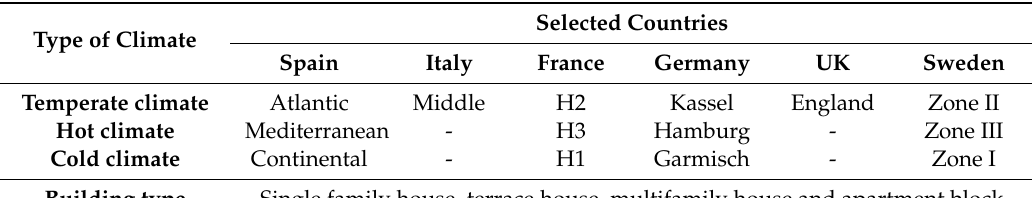
Table 2. Climate conditions of the analysed countries based on TABULA.